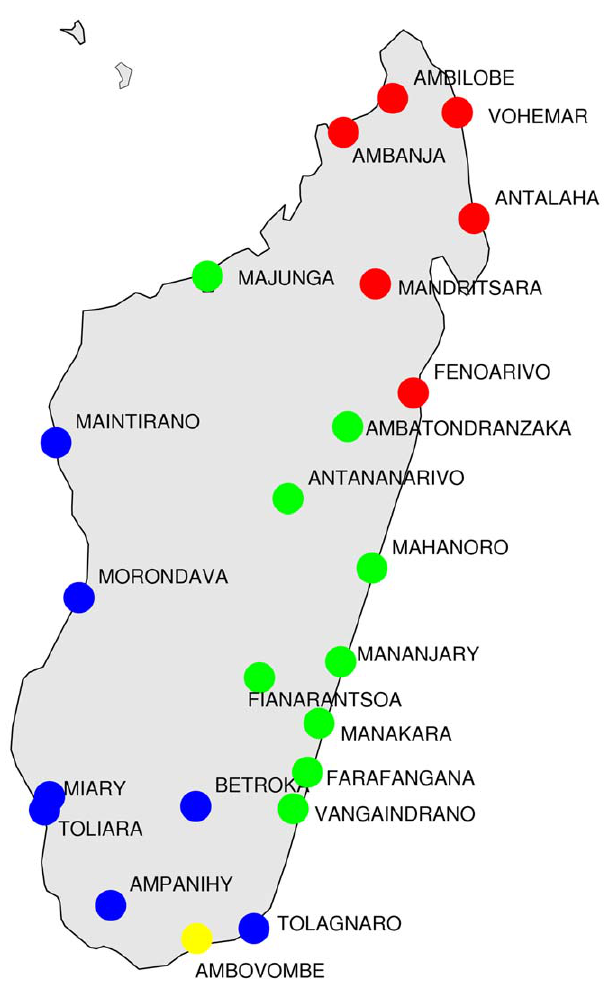
Figure 2. Geography of Malagasy dialects. The locations of the 23 dialects are indicated with the same colors as in Fig. 1. Each dialect is identified by the name of the town where it was collected.